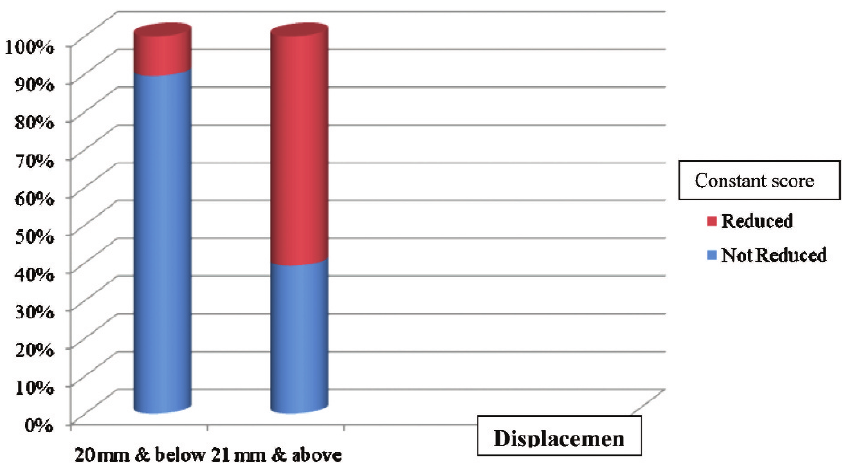
Figure 3 - Clavicle fracture displacement and Constant